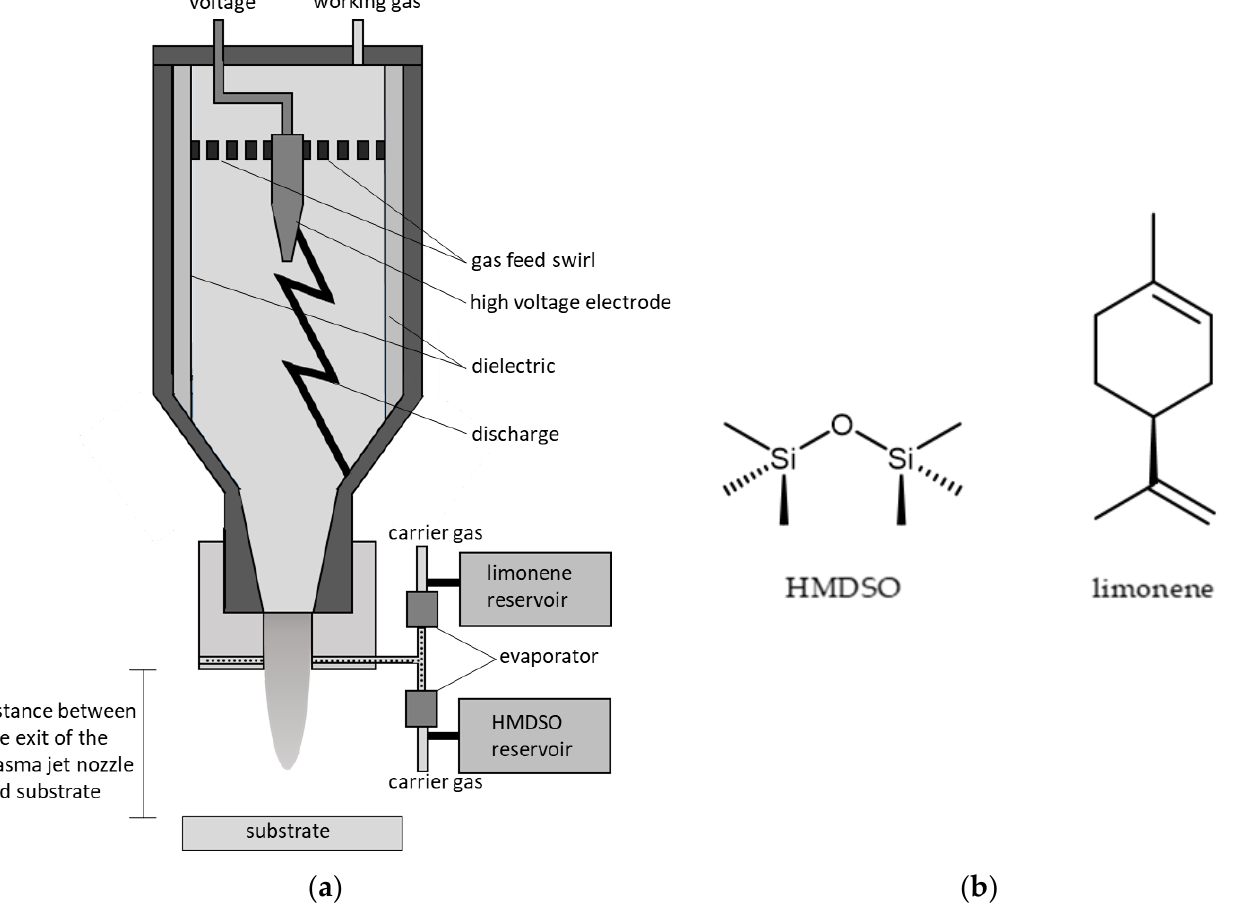
Figure 1. ( a ) Schematic of the plasma jet system for deposition. ( b ) Chemical structure of HMDSO and lim.